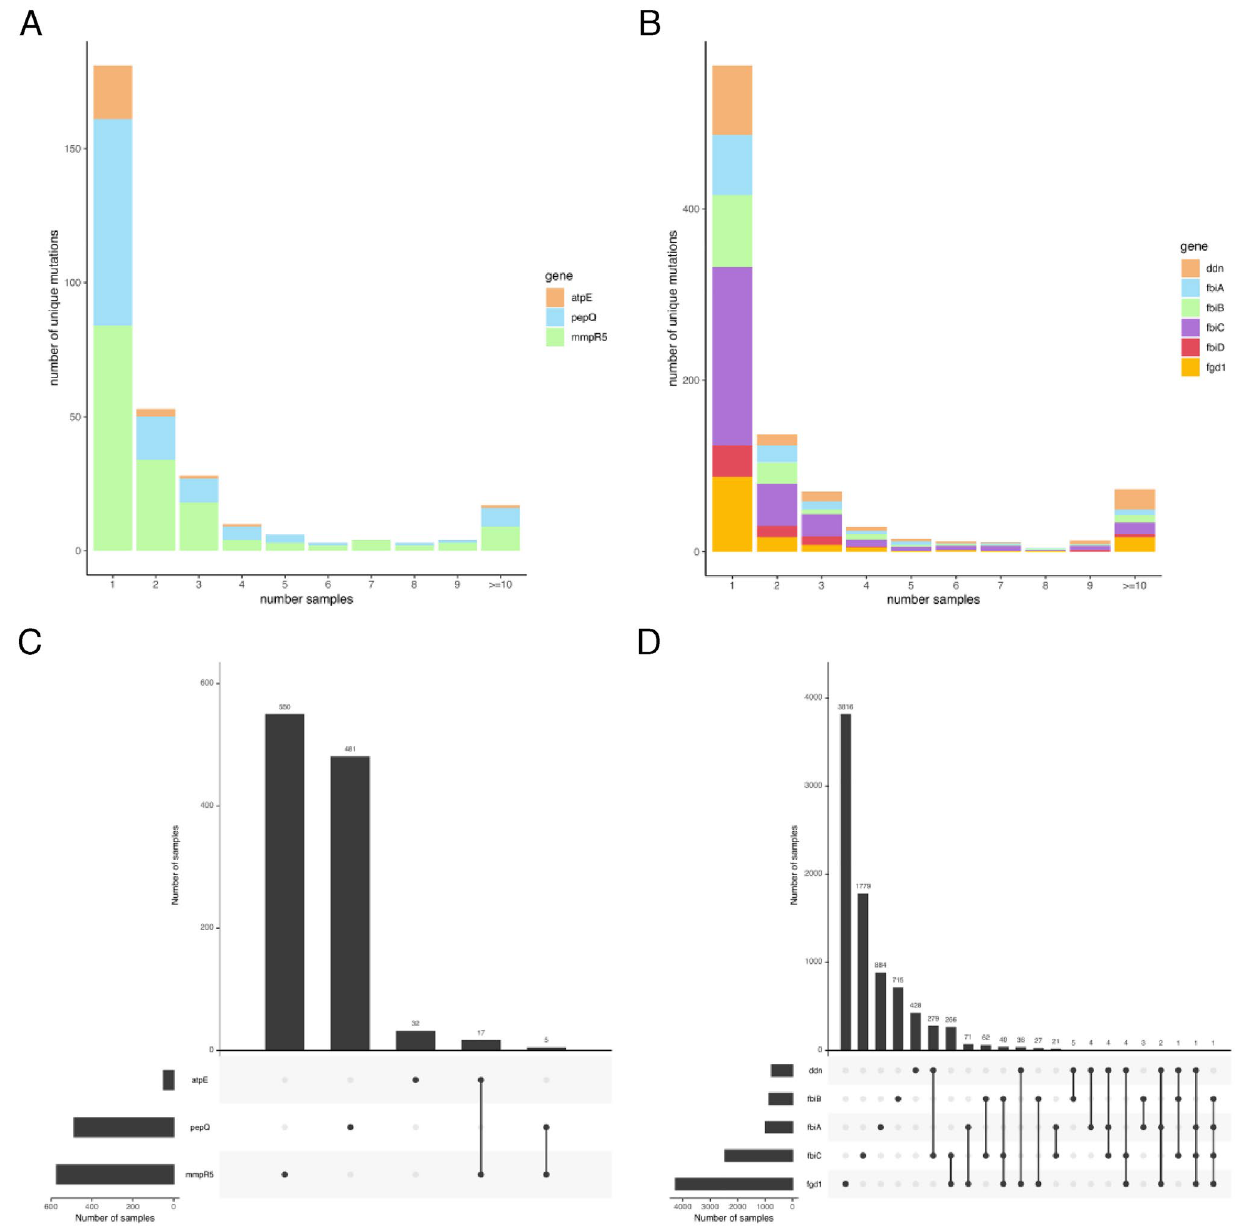
Figure 1. ( A ), ( B ) Frequency of mutations identified across data set. The vertical axis is the number of mutations that are found in 1 to 10 or more isolates (horizontal axis). Colours represent the different genes, each bar showing the distribution of those mutations in the candidate genes for each drug (A = Bedaquiline (BDQ), B = Delamanid (DLM)/Pretomanid (PTM)). ( C ), ( D ) Intersection of mutations in the different genes by sample. Bars represent the number of samples that hold mutations in each gene, or combination of them (horizontal bars show total samples with mutations in each gene); C = BDQ, D =